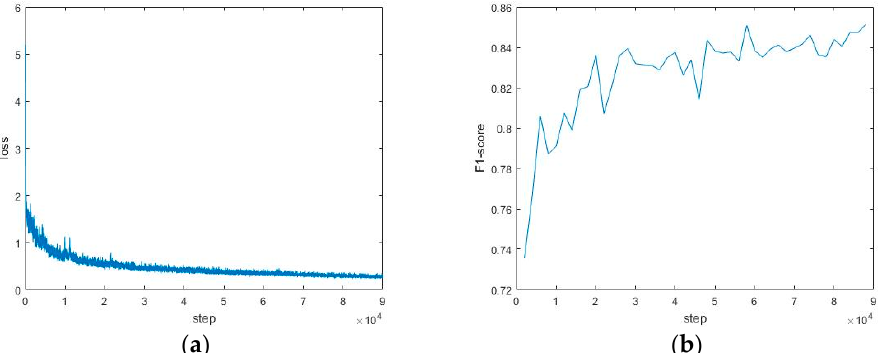
Figure 6. The training and testing curves of the MSRA-TD500 dataset. ( a ) The loss curves in training; ( b ) the F1-score curves in testing.